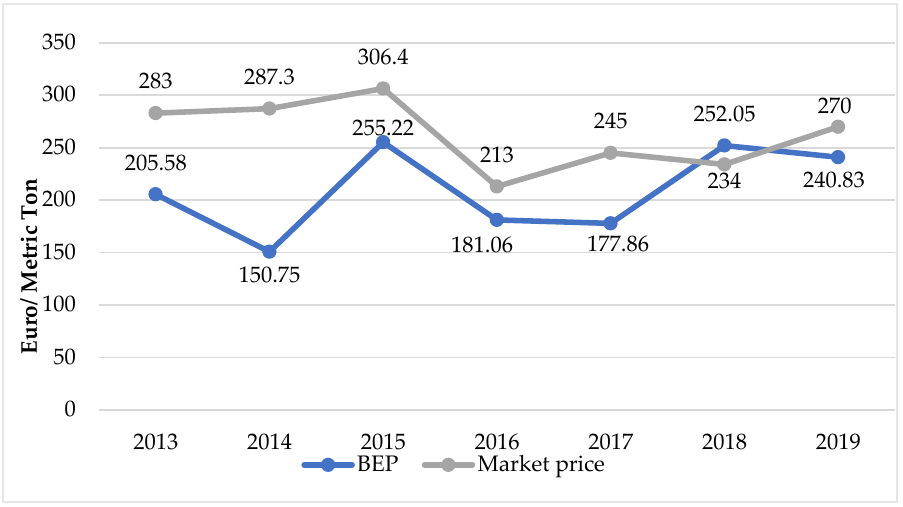
Figure 5. Break-even price (EUR/Ton) of durum wheat on sample farm.